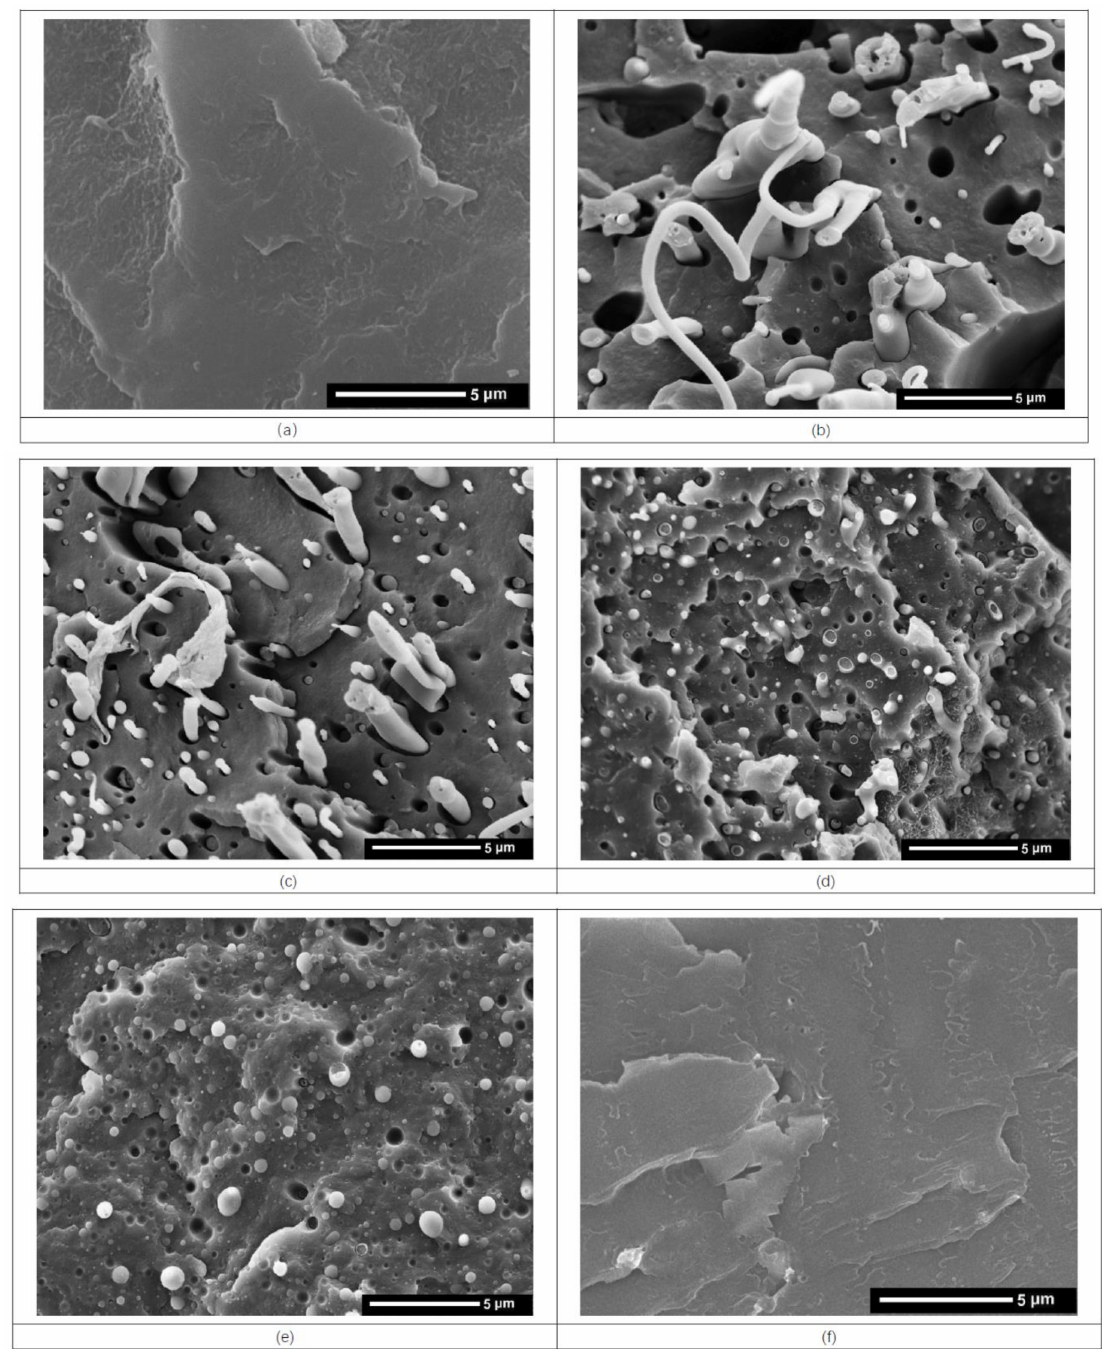
Figure 7. SEM images of the molded sample. ( a : pure PP; b : PPC; c : PCM; d : PCG; e : PCE; f : pure